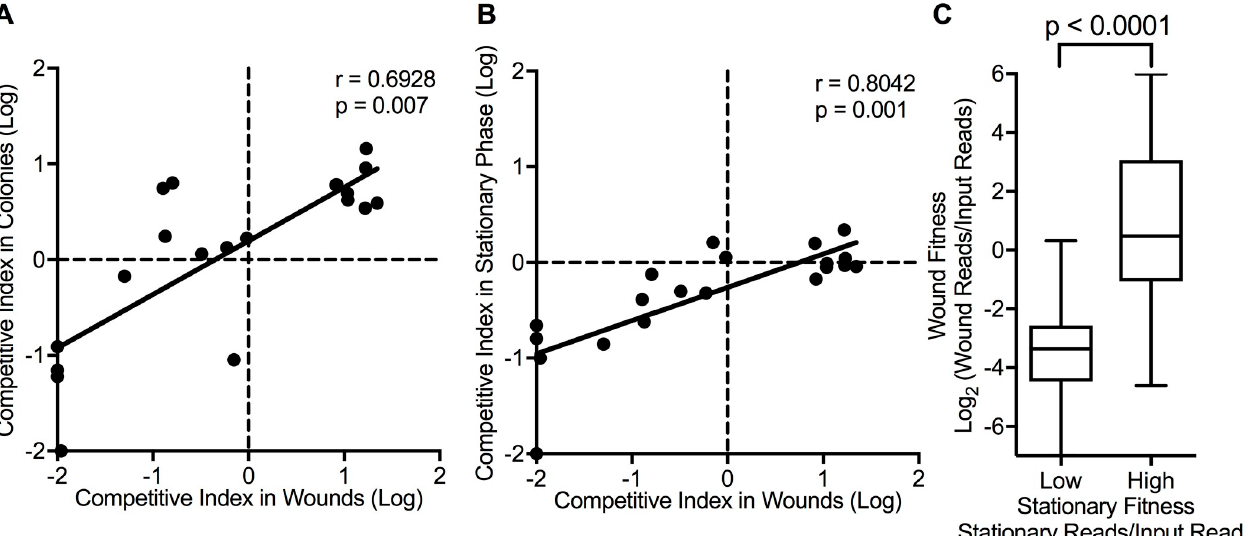
Fig 6. High-density growth and wound fitness correlate. (A and B ) Relationship between the competitive index of mutants in colonies ( A ) or stationary phase cultures ( B ) and in wound infections. Spearman correlation and significance values were calculated using mean competitive index of each mutant. C. The wound competitive index of the 100 mutants exhibiting the lowest and highest stationary phase culture fitness (as measured by Tn-seq). Box plots indicate median, and 25 th and 75 th percentiles; error bars show the range of wound competitive index. Significance determined by Mann-Whitney analysis.